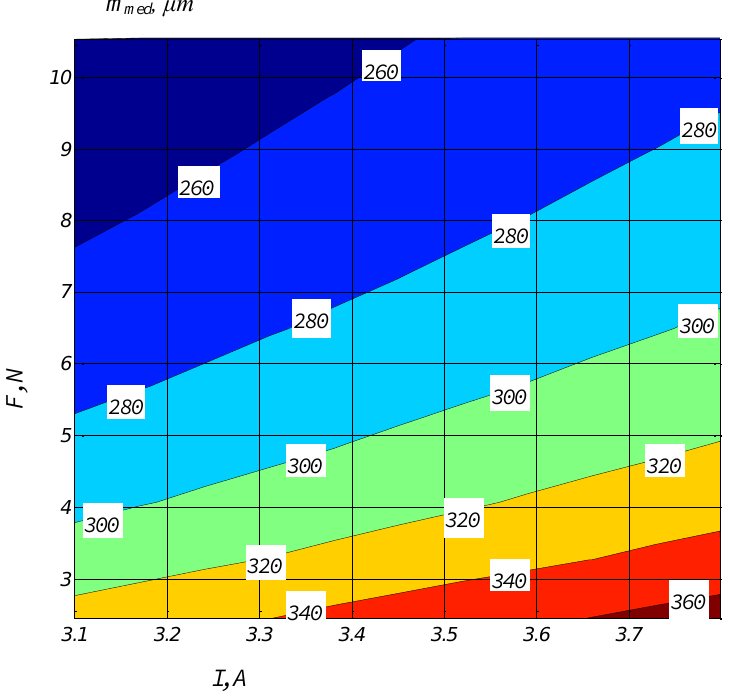
Figure 10. The influence of the average current I and the average voltage F on the width of the slot in the middle of the thickness of the blank ( H = 20 mm, T on = 12 µs, T off = 30 µs, v = 2500 mm/min, U = 135 V).